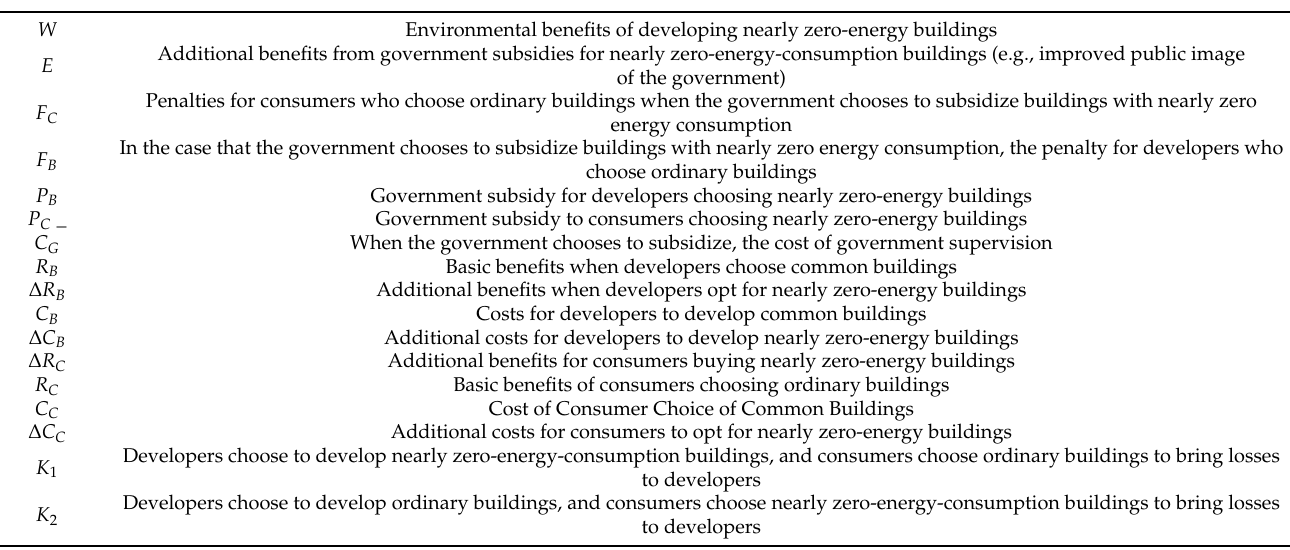
Table 1. Description of parameter settings.